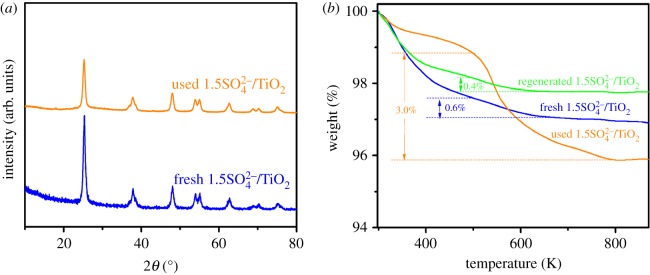
XRD diffraction patterns (a) and TG curves (b) of the fresh and used 1.5SO42−/TiO2 catalysts.